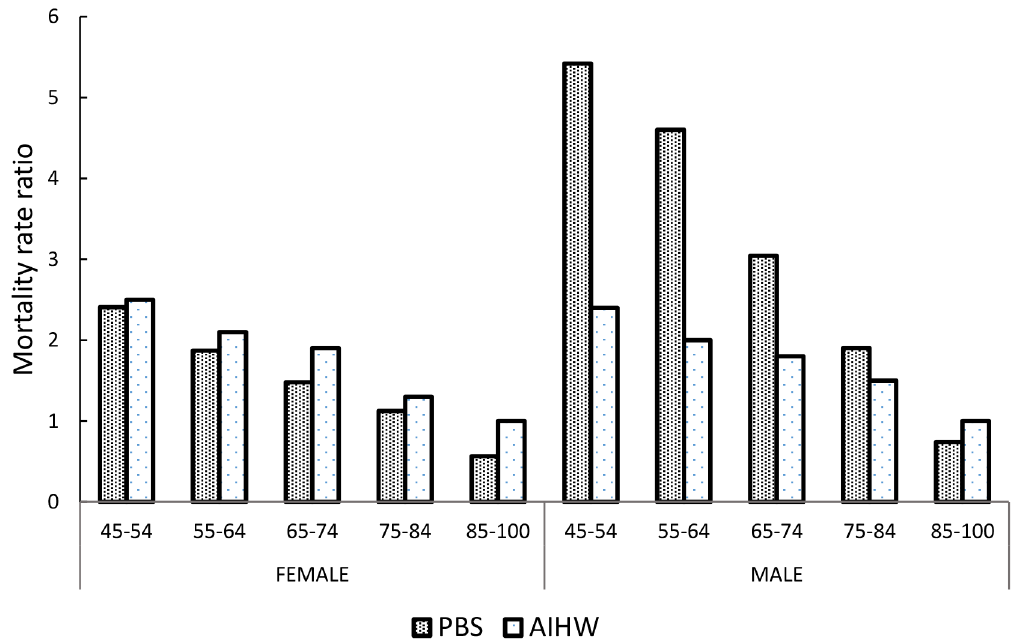
Figure 2: A comparison of PBS age and sex specific mortality rate ratios with similar data derived from the Australian Institute of Health and Welfare report for type 2 diabetes